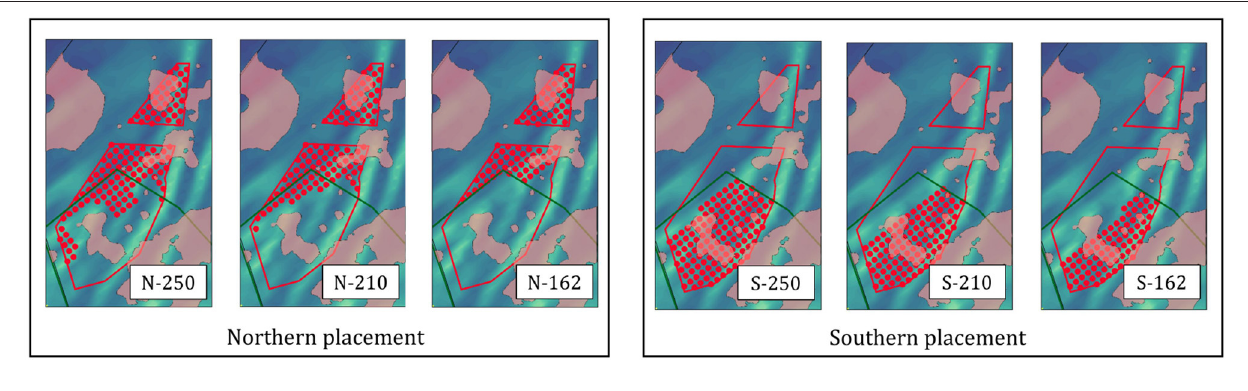
FIGURE 4 | Mapping of the monopiles over the NCA under two scenarios of localization of the wind farm: Northern placement (N) avoids the gravel beds while Southern placement (S) overlays with the gravel beds. For each placement, we consider three types of installed nameplate capacity, resulting in 162, 210, and 250 monopiles. These scenarios are referred to as N-250, N-210, N-162, S-250, S-210, S-162. In each case, the total amount of delivered energy by the OWF at the NCA is fixed at 2100